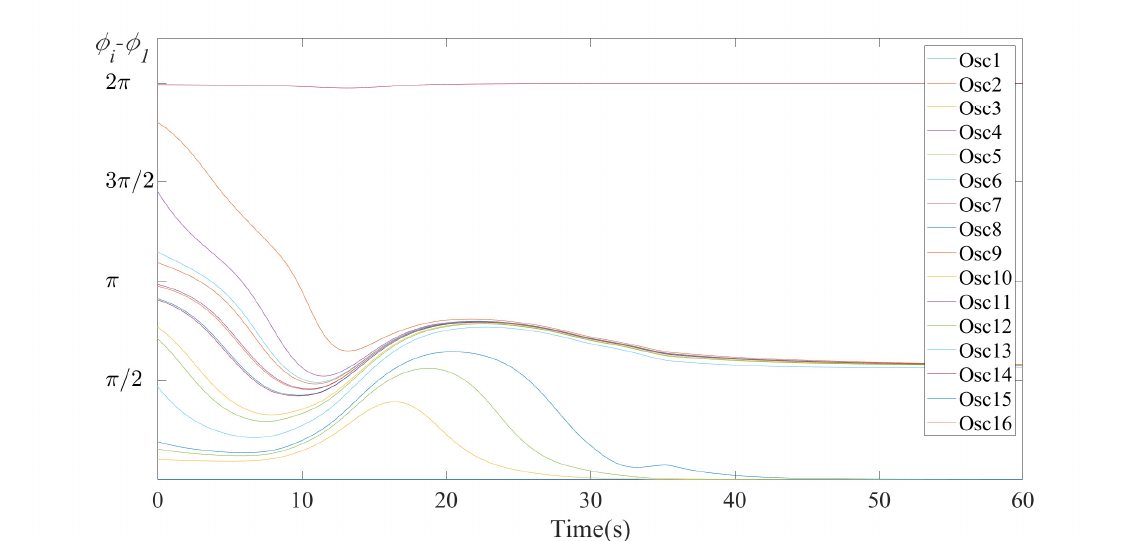
Figure 10. The simulation results are shown as a particular stable 2-cluster partitions, where each curve represents the phase difference φ i − φ j , for i = 1,2,...,16, j = 1, when a 1 = 5, a 2 = 11.